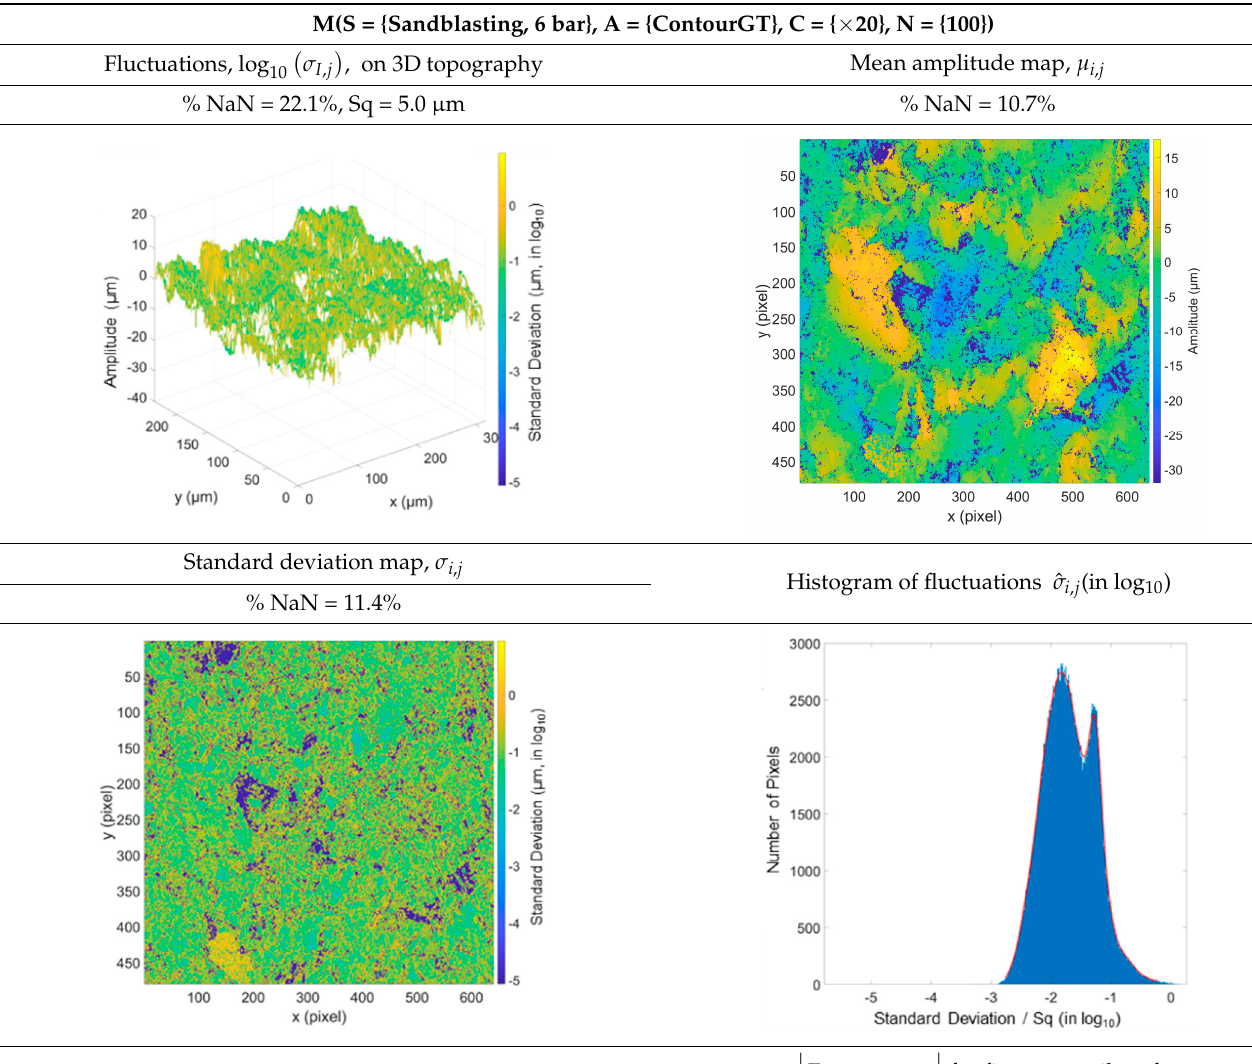
Table A2. Sandblasted Surface, 6